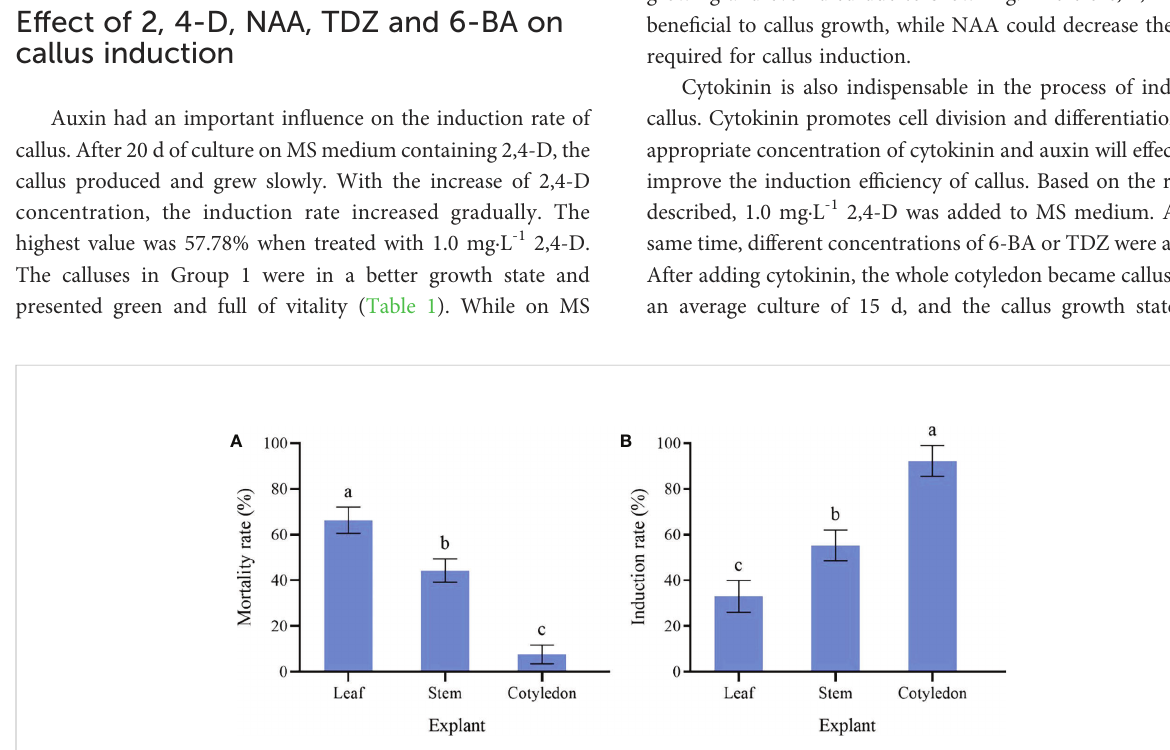
FIGURE 2 Effect of different explant of sterile seedling on P. lacti fl ora callus induction. (A) mortality rate of callus induced by different explants, (B) induction rate of callus induced by different explants, the different letters within a column marked signi fi cant differences (p <